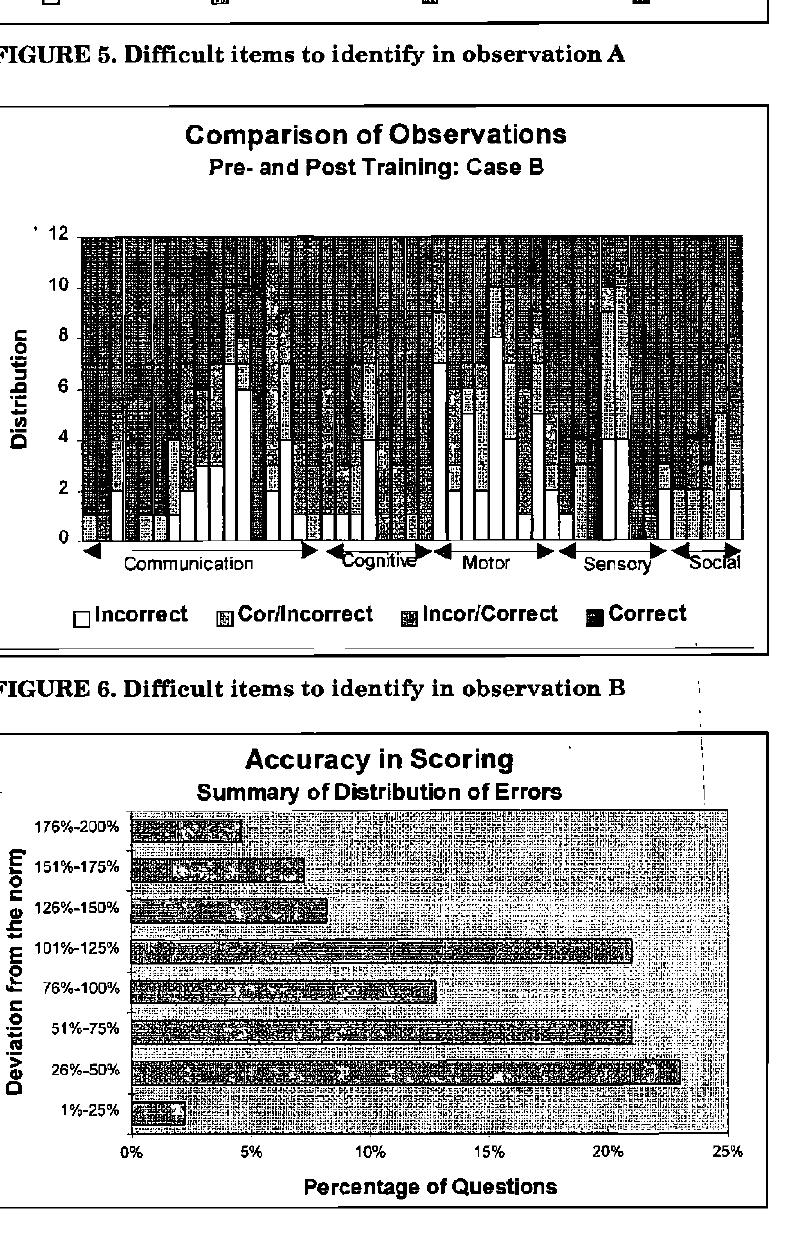
FIGURE 7. Categorised results of the distribution of